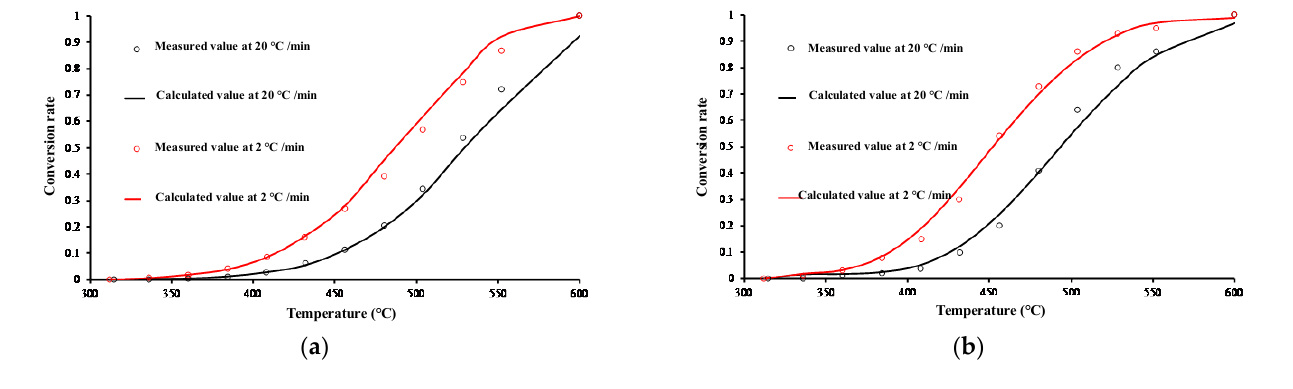
Figure 7. Dynamic fitting effect of gas hydrocarbons generated using pyrolysis of oil shale. ( a ) CH 4 ; ( b ) C 1–5 . Table 2. Kinetic parameters of hydrocarbon generation during oil shale pyrolysis.